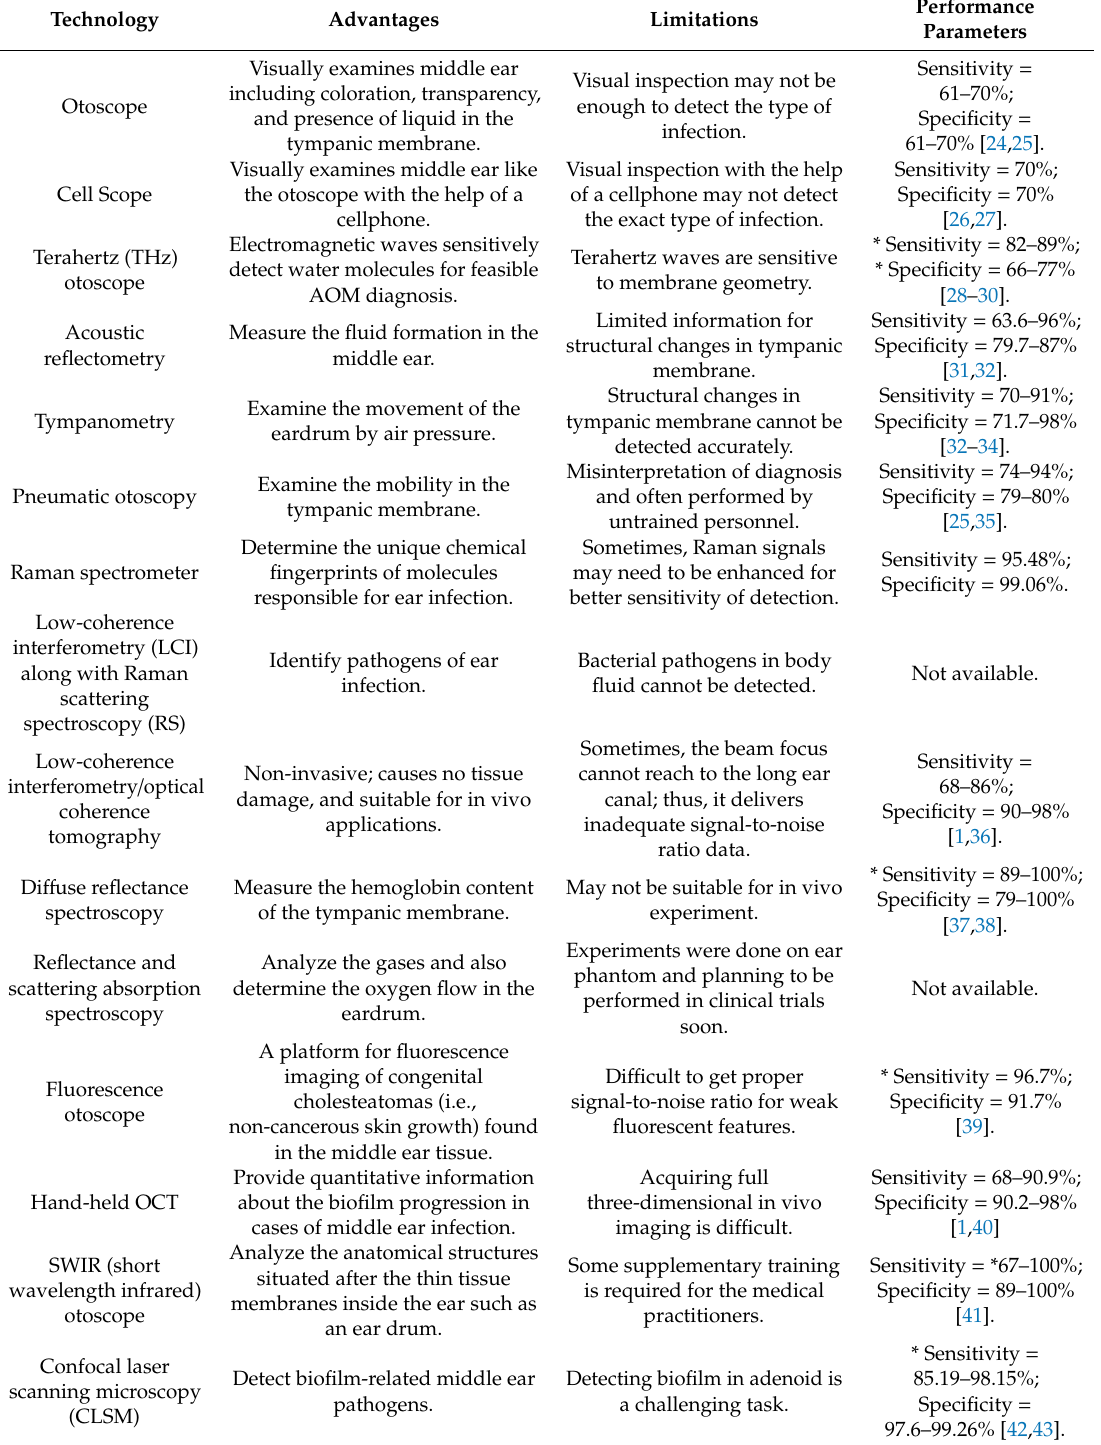
Table 1. List of current and emerging optical techniques for the detection of ear infection. OCT,